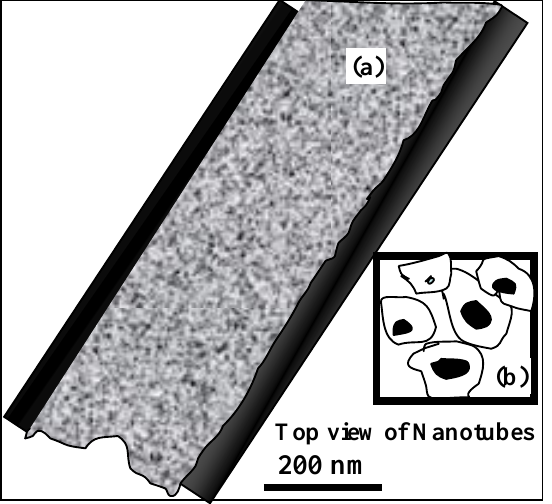
Figure 3. ( a ) Schematic microstructure of Ce-NT and ( b ) insert represented as the top-view of